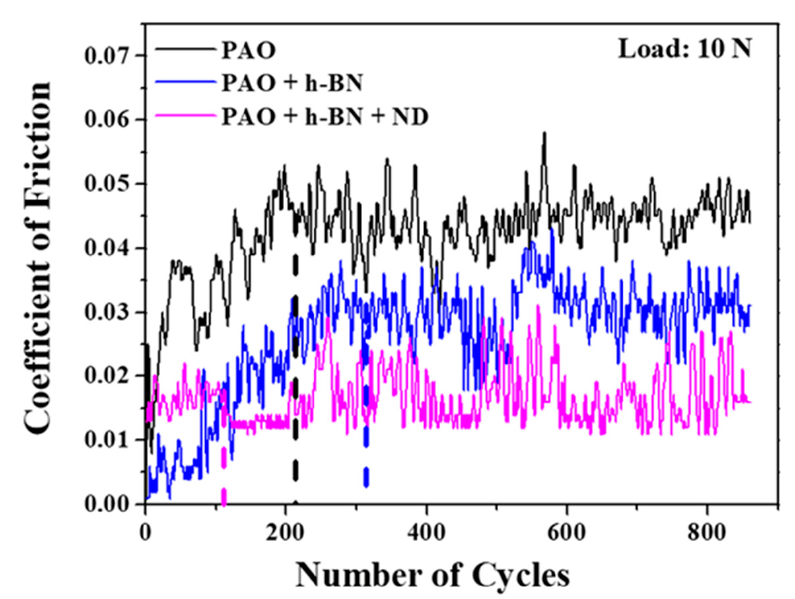
Figure 13. Coefficient of friction as a function of the number of cycles for PAO base oil, PAO + h-BN and PAO + h-BN + ND nanolubricants (tests conducted at 10 N load). The vertical dotted lines intersecting the x -axis indicate the onset of steady state condition.